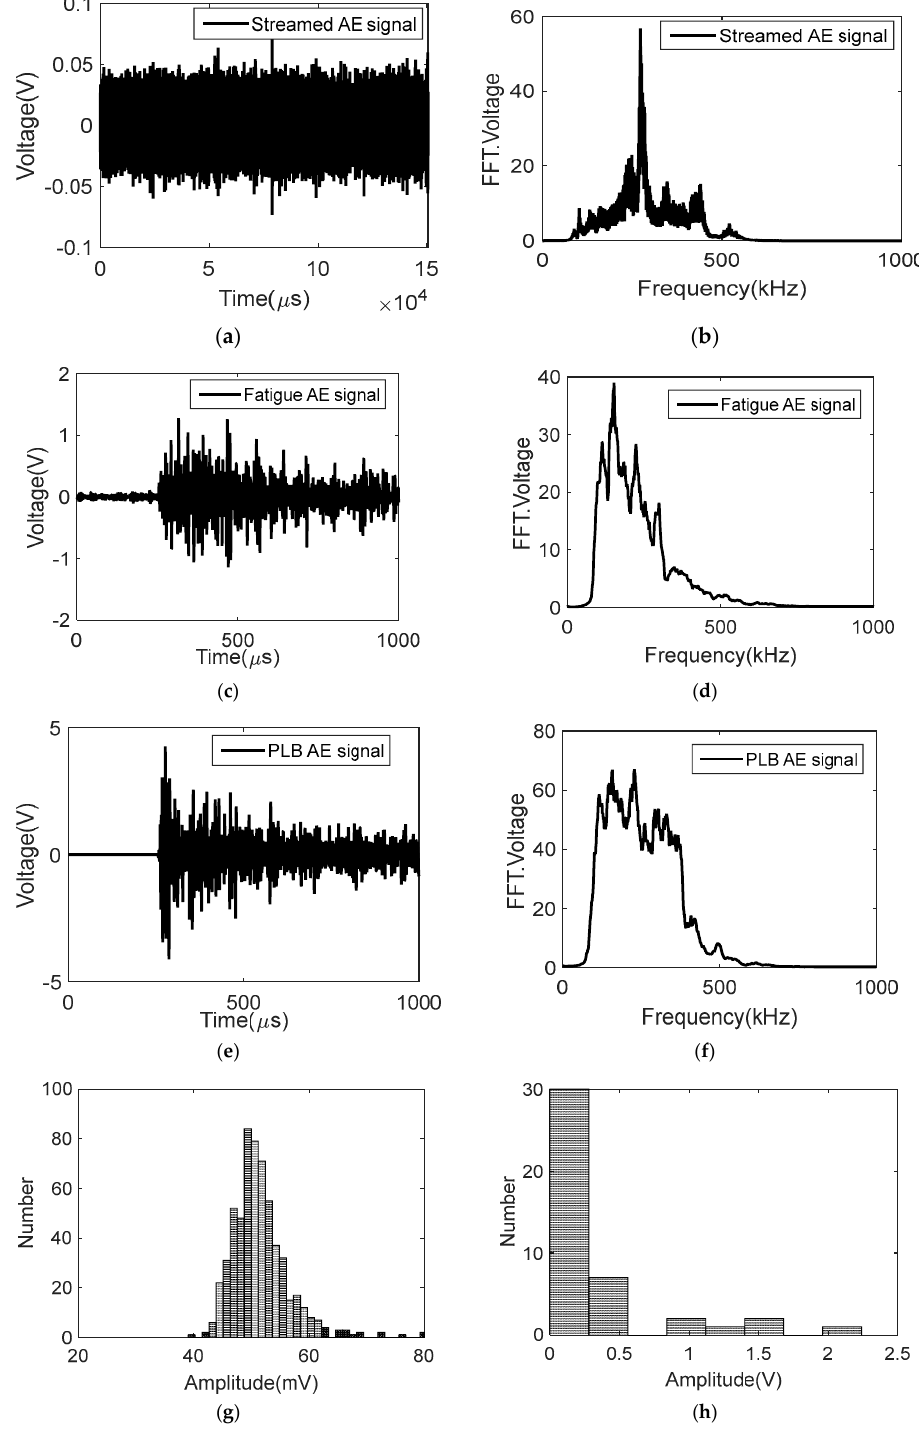
Figure 4. Examples of AE signals and frequency spectra ( a , b ) streamed AE signal obtained from the NAVAIR gearbox test, ( c , d ) signals due to crack growth obtained from the UIC fatigue test, ( e , f ) signals due to the pencil lead break (PLB) testing obtained from the UIC fatigue test, and ( g , h ) the histograms of AE amplitudes from the NAVAIR gearbox test and the UIC fatigue test. FFT: fast Fourier transform.